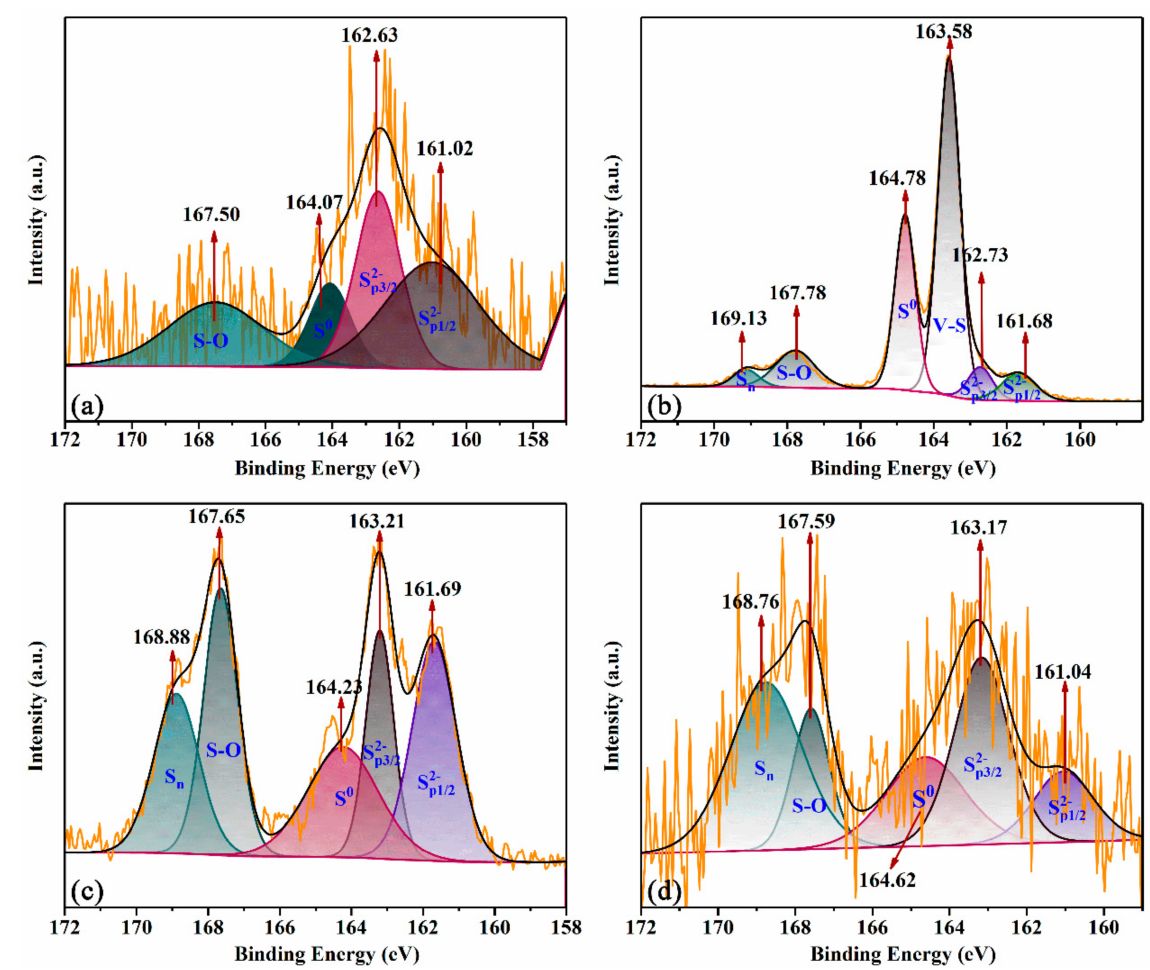
Figure 5. The XPS spectra from optimum amount of Na 2 CO 3 at ( a ) 1 h; ( b ) 4 h; ( c ) 8 h; ( d ) 9